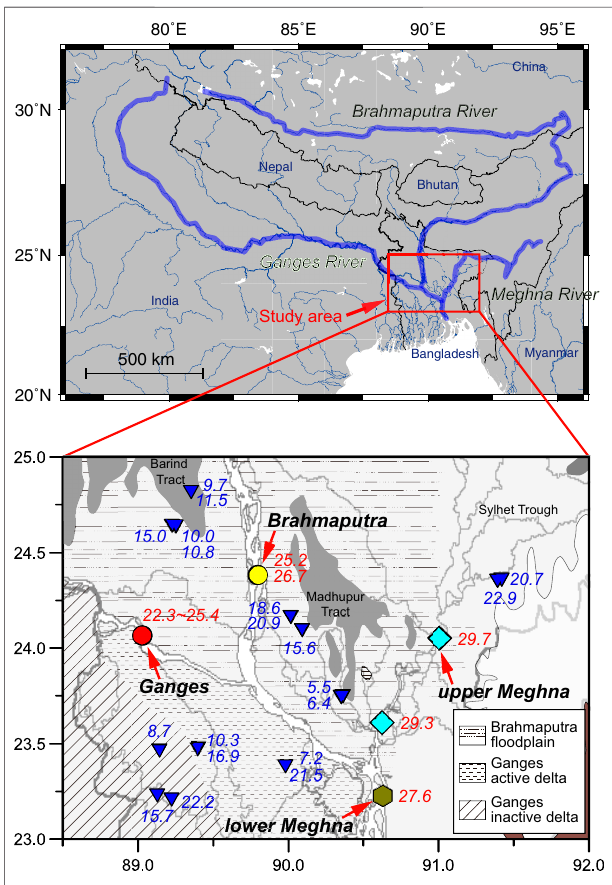
FIGURE 1 | Maps of the Ganges – Brahmaputra – Meghna river system (modi fi ed after Yoshimura et al., 2021) showing geomorphologic units (Paul et al., 2010) as well as sampling locations for groundwater (blue triangles) and river water of the Ganges (red circle), Brahmaputra (yellow circle), upper Meghna (blue diamond), and lower Meghna (green hexagon) Rivers. Blue and red numbers represent δ 7 Li compositions of groundwater and river water, respectively. The light gray areas are the major Pleistocene terraces (Barind and Madhupur